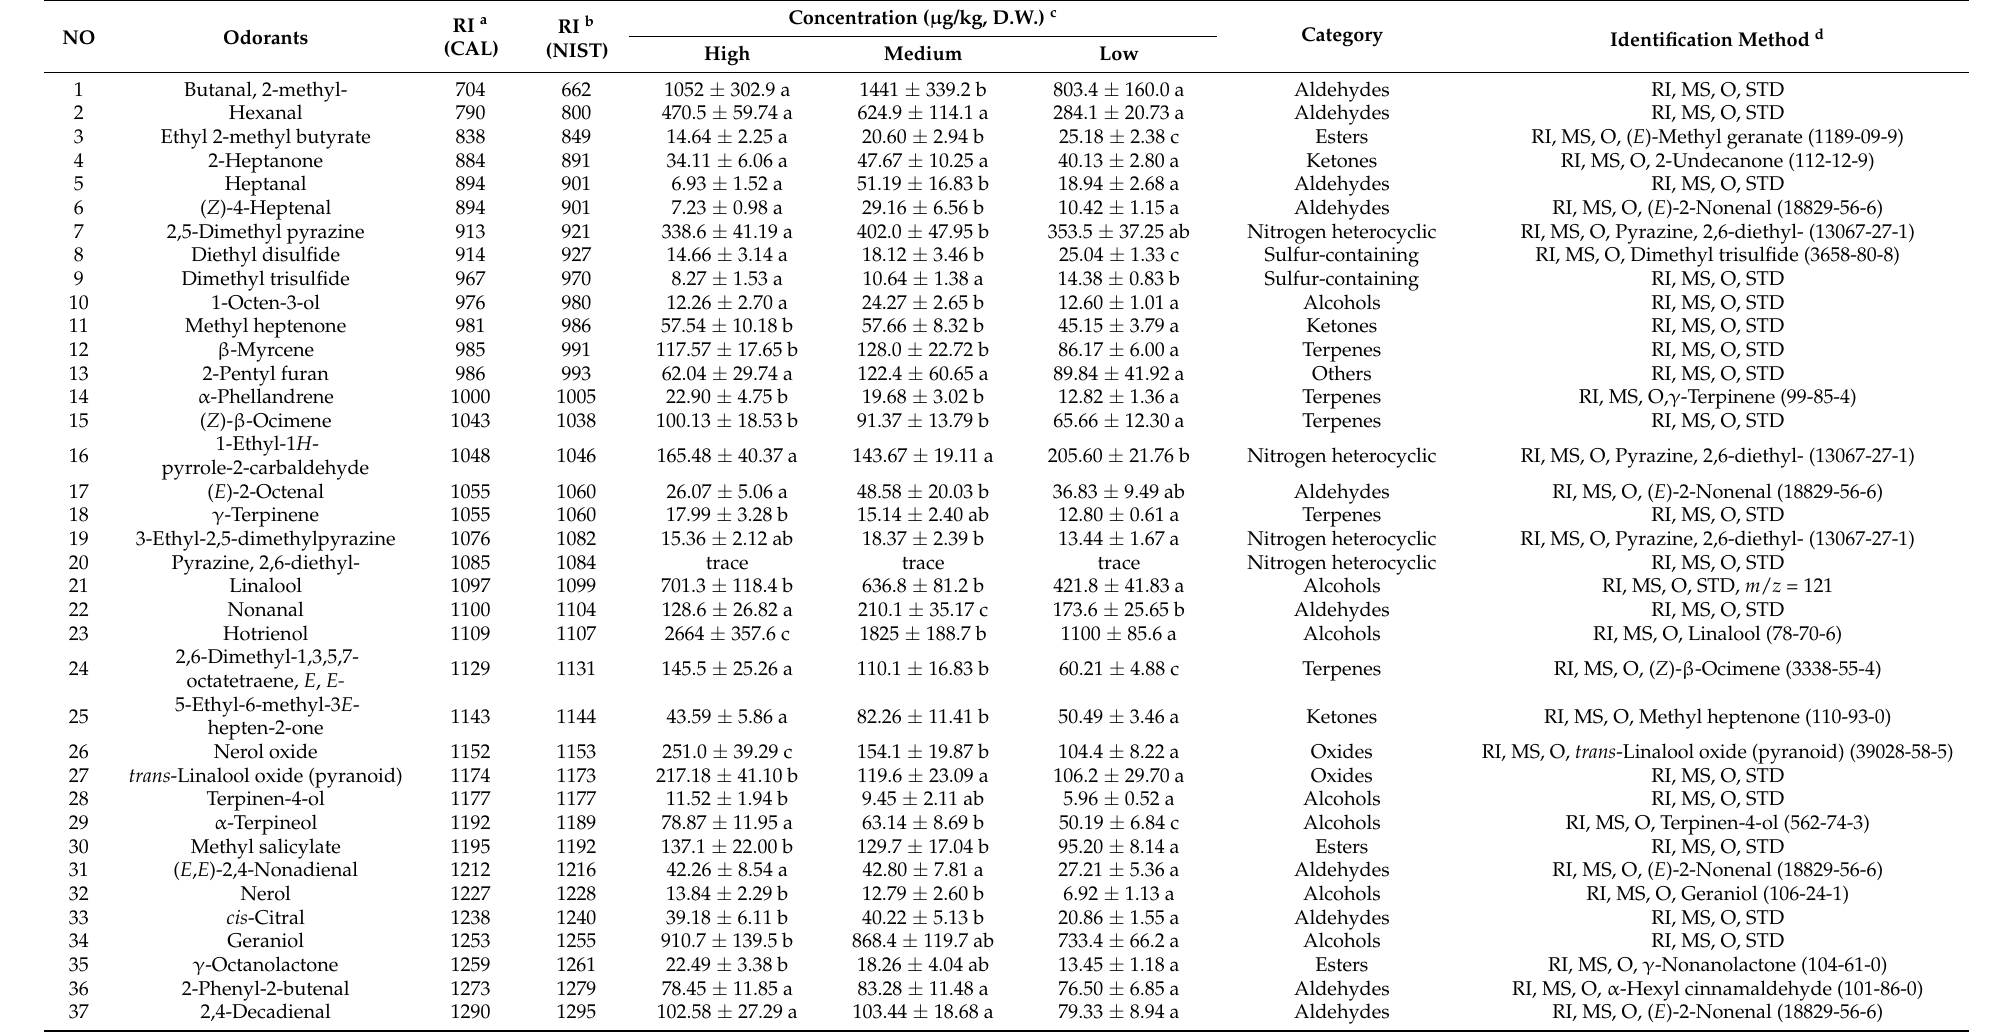
Table 1. Qualitative and quantitative analysis of aroma of Lingtou Dancong tea product from plants grown at different